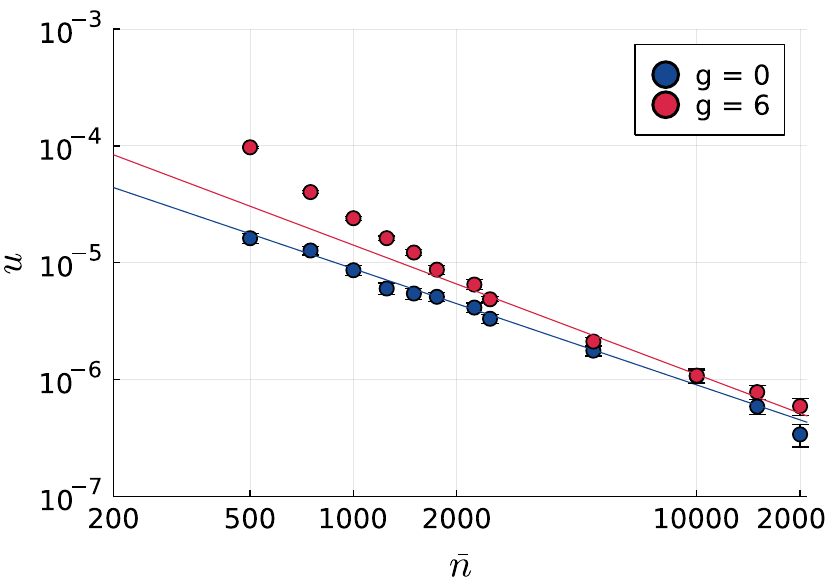
Figure 9. A log-log plot of the potential coefficients u as a function of the volume per slice ¯ n for the type III ensemble with spatial genus g = 0 , 6 . The straight lines are best fits of the form u = c · ¯ n β , where only the data points with ¯ n ≥ 1750 are taken into account for the